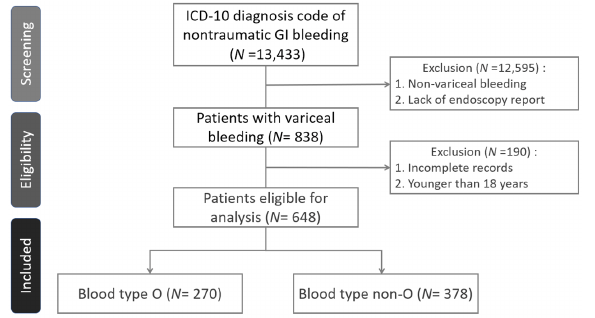
Figure 1. Flow diagram of case selection. Table 1. Number of emergency room visits.